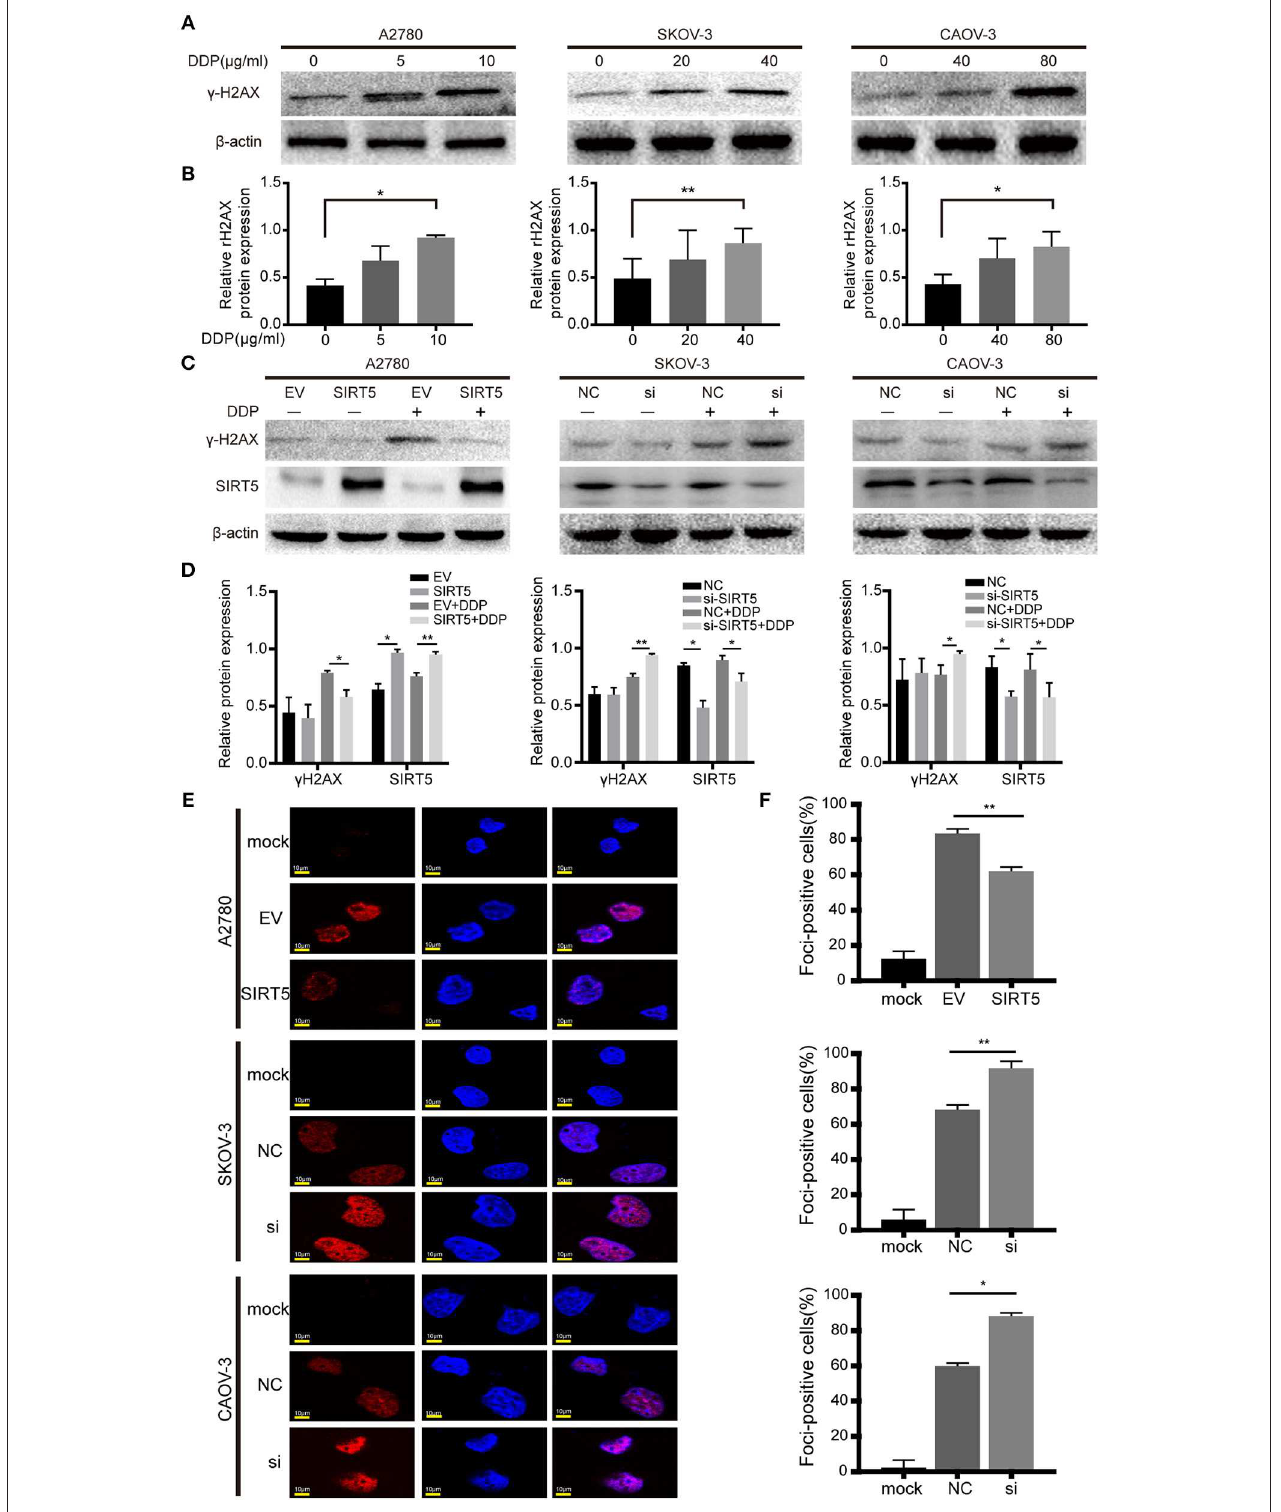
FIGURE 4 | SIRT5 suppresses cisplatin induced DNA damage. (A) The γ -H2AX protein levels were upregulated during exposure to cisplatin in three ovarian cancer cells assessed by western blot and (B) the relative gray values were shown in histogram. (C) The transfected cells were treated with or without IC50 dose of cisplatin for 24h. The γ -H2AX protein levels were assessed by western blot and (D) the relative gray values were shown in histogram. (E) The γ -H2AX foci formation was